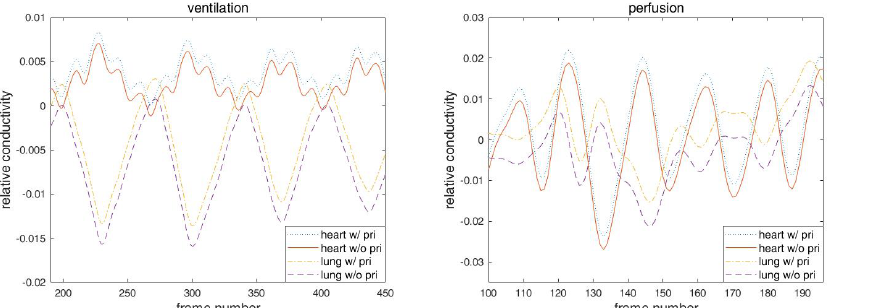
Figure 10. The time trace plots of a pixel in the right lung region and a pixel in the heart region from the reconstructions. Two pixels are marked with squares in the first image of Figure 12. Left is the plot from the ventilation data and the right one is for the breath-holding data. In both plots, from the top to the bottom, each graph represents the time trace of the pixel in the heart with and without a prior, and the time trace of the right lung pixel with and without a prior. The plots of the lung pixels in the perfusion time trace plot are shifted upward by 0.02 in order to better demonstrate the out-of-phase